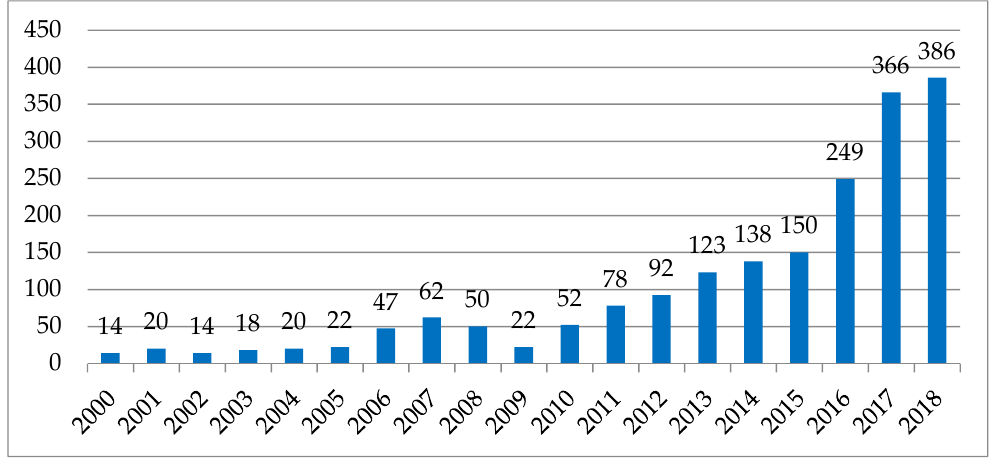
Figure 2. Number of patent.